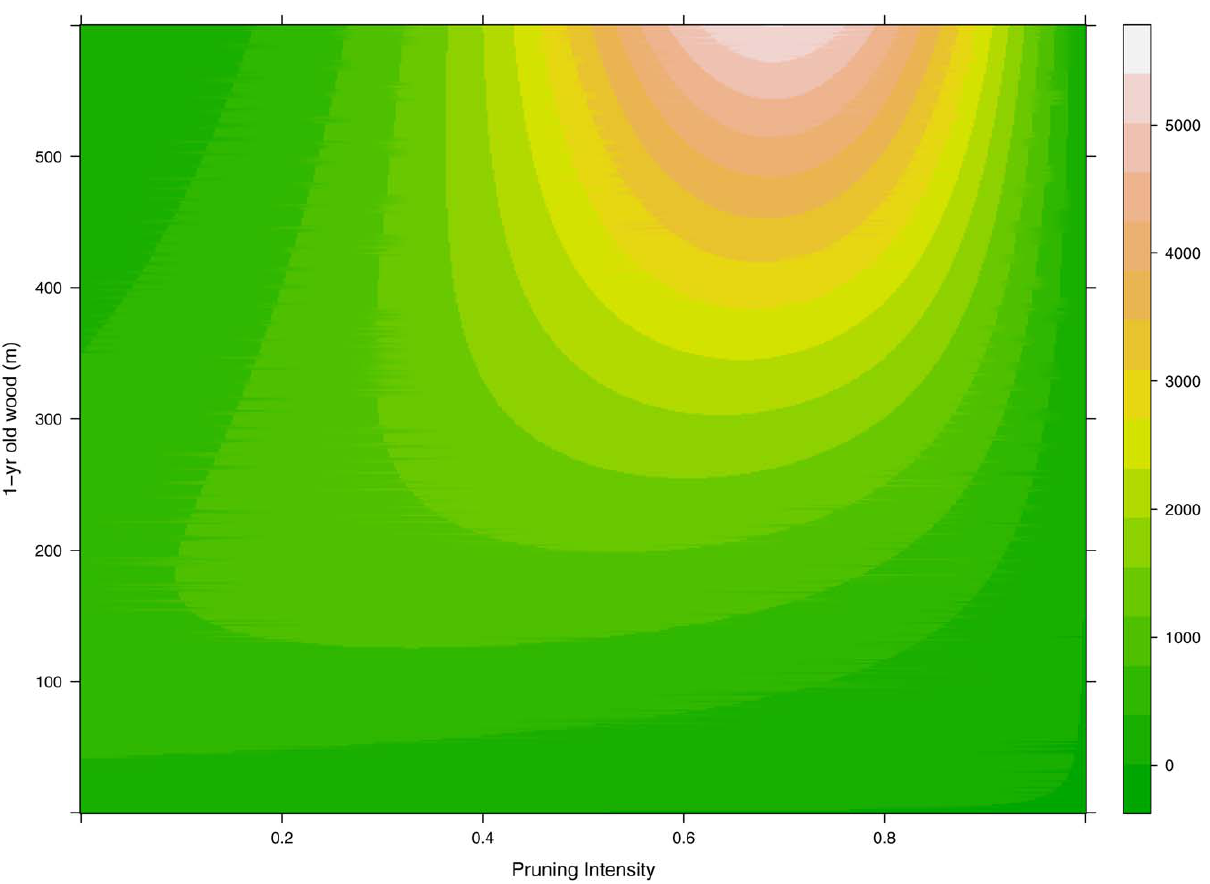
Figure 2. Estimated abundance of long shoots (N LS ), in the growing season of a virtual peach Prunuspersica tree as function of 1-yr old wood before winter pruning (L w1 ) and pruning intensity (PI,i.e. fraction of 1-yr old shoot removed before bud break).